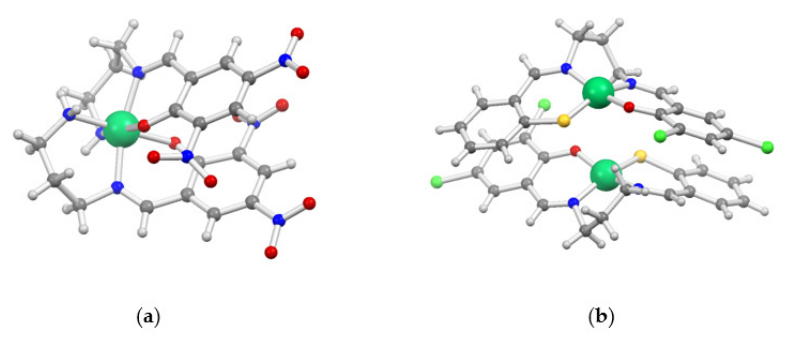
Figure 6. Molecular structures of ( a ) [Ni( NO2 L) 2 ] ( NO2 L – from 3,5-diNO 2 -salH and tn), CSD/CCDC TIPXUL/128426 [95], and ( b ) [Ni(3,5-Cl 2 -thiosaltn)] (N 2 OS ligand derived from 3,5- Cl 2 -salH, H-thiosalH and tn, which are shown as head-to-tail dimeric assembly), CSD/CCDC LOBLET/145689 [38]. Reproduction of the structures with Mercury ® 4.3.1 software [71], color code: Ni = aquamarine, Cl = green, S = yellow, O = red, N = blue, C = gray, H =